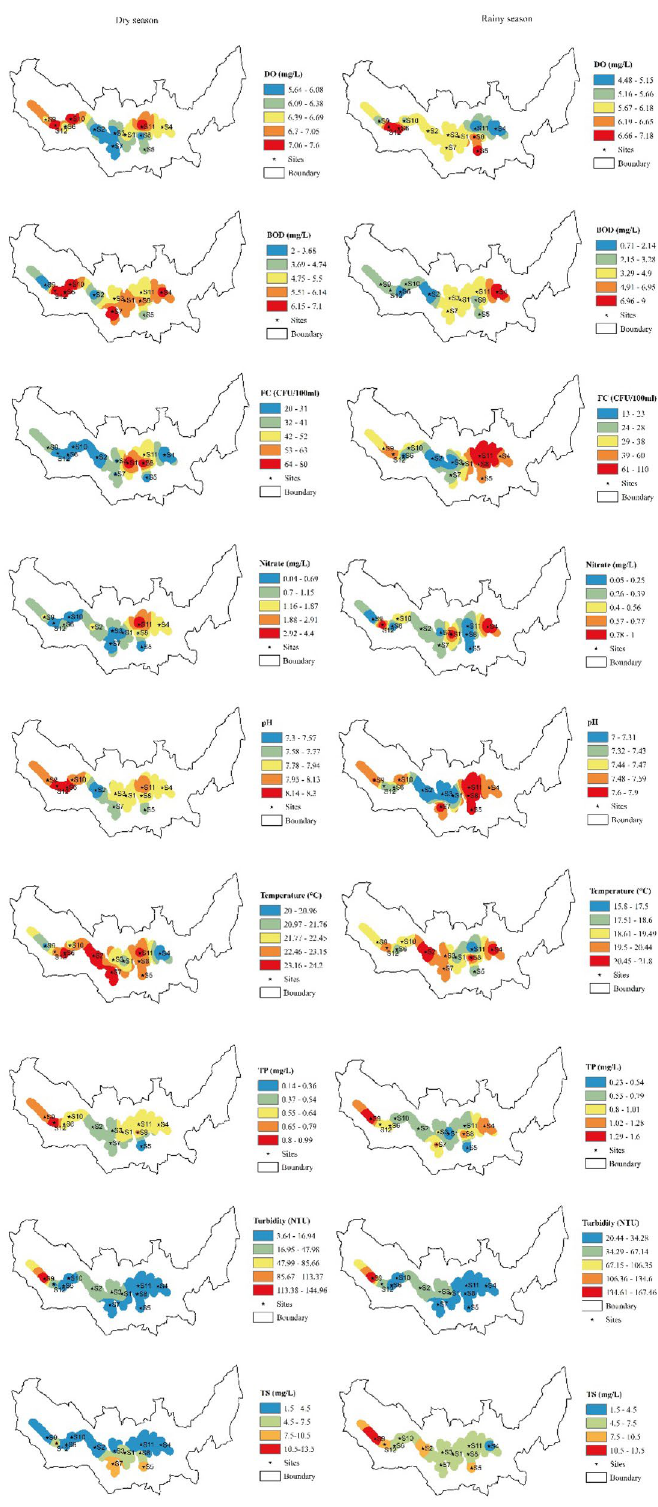
Figure 2. Spatial distribution of the parameters of water quality on Lake Muhazi. Authors’ self-implementation with the ArcGIS software version 10.8 (http:// www. esri.